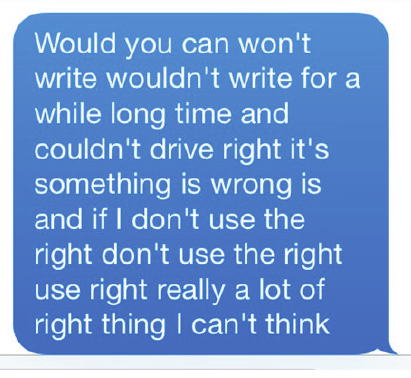
Figure 1: Text message sent at the time of stroke (autocorrection: on).